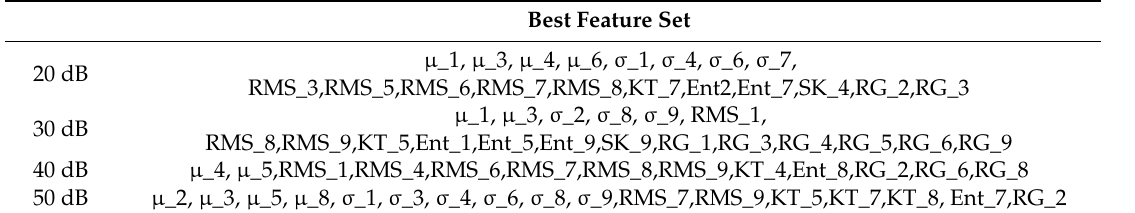
Table 2. Particle swarm optimization (PSO) selected best feature